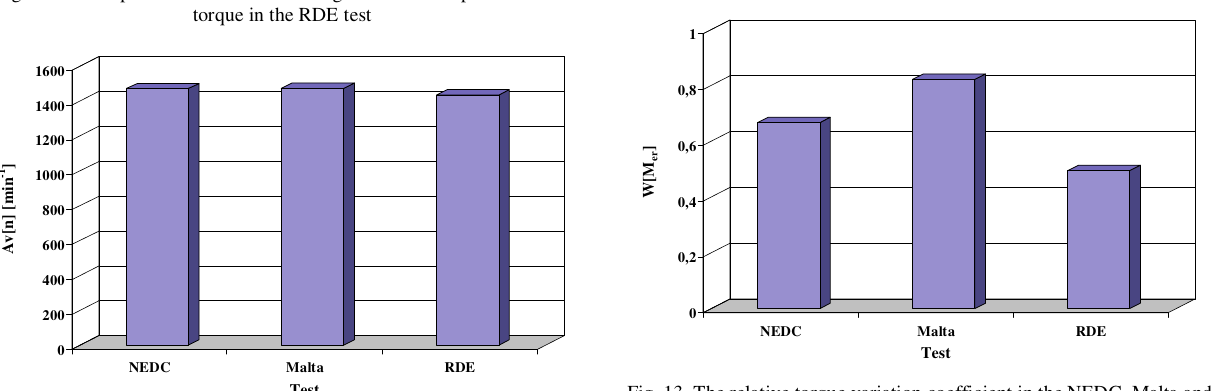
Fig. 13. The relative torque variation coefficient in the NEDC, Malta and RDE